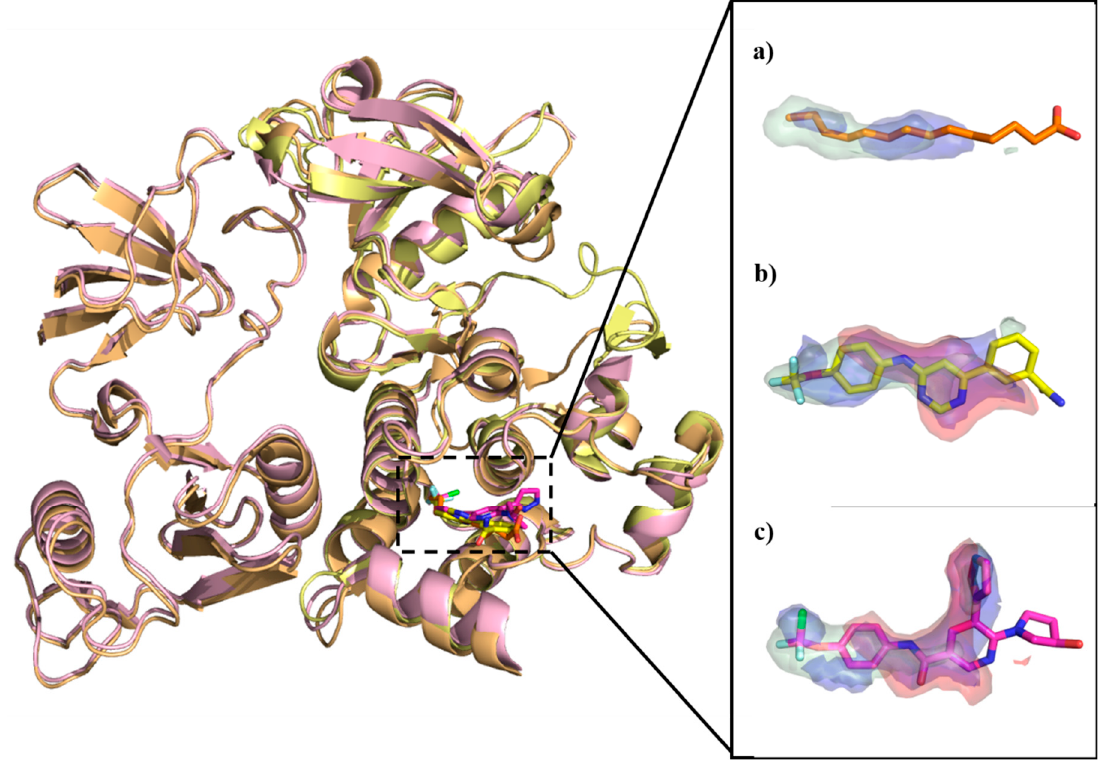
Figure 9. Superposition of Abl crystal structures co-crystallized with ( a ) the myristic acid (PDB entry, 1OPK [20]) and two allosteric inhibitors, ( b ) GNF-2 (PDB entry, 3K5V [60]), and ( c ) ABL001 (PDB entry, 5MO4 [67]) rendered in orange, yellow and pink cartoon respectively. In the insert, GRID MIFs probes for each crystal structure corresponding to hydrophobic, HB acceptor, and HB donor interactions are displayed in green, blues, and red surface, respectively. A cut-off value of –1.5 kcal/mol, − 4.5 kcal/mol, and − 3.0 kcal/mol is set for CRY-, N1-, and O-GRID probes, respectively.